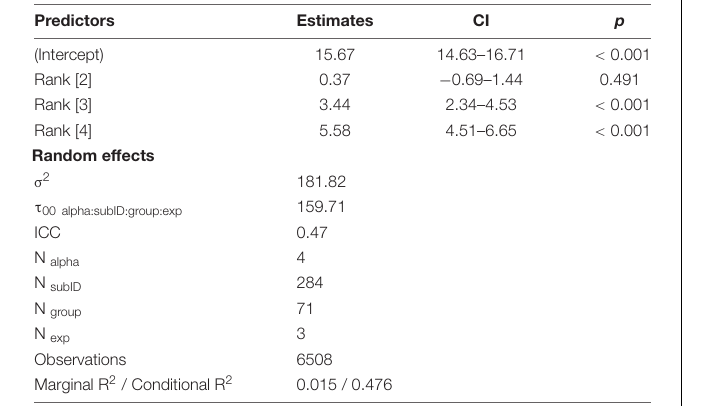
TABLE 6 | Tapper rank as a predictor of their SD async difference.